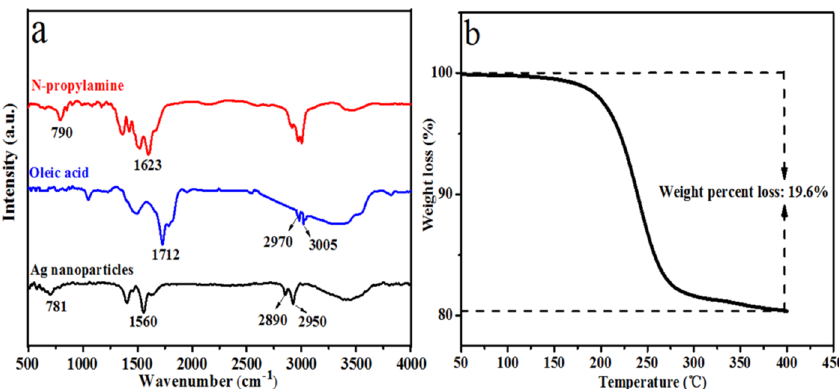
Figure 3. ( a ) FTIR spectra of n-propylamine, oleic acid and the Ag nanoparticles; ( b ) TGA curve of as-synthesized Ag nanoparticles.